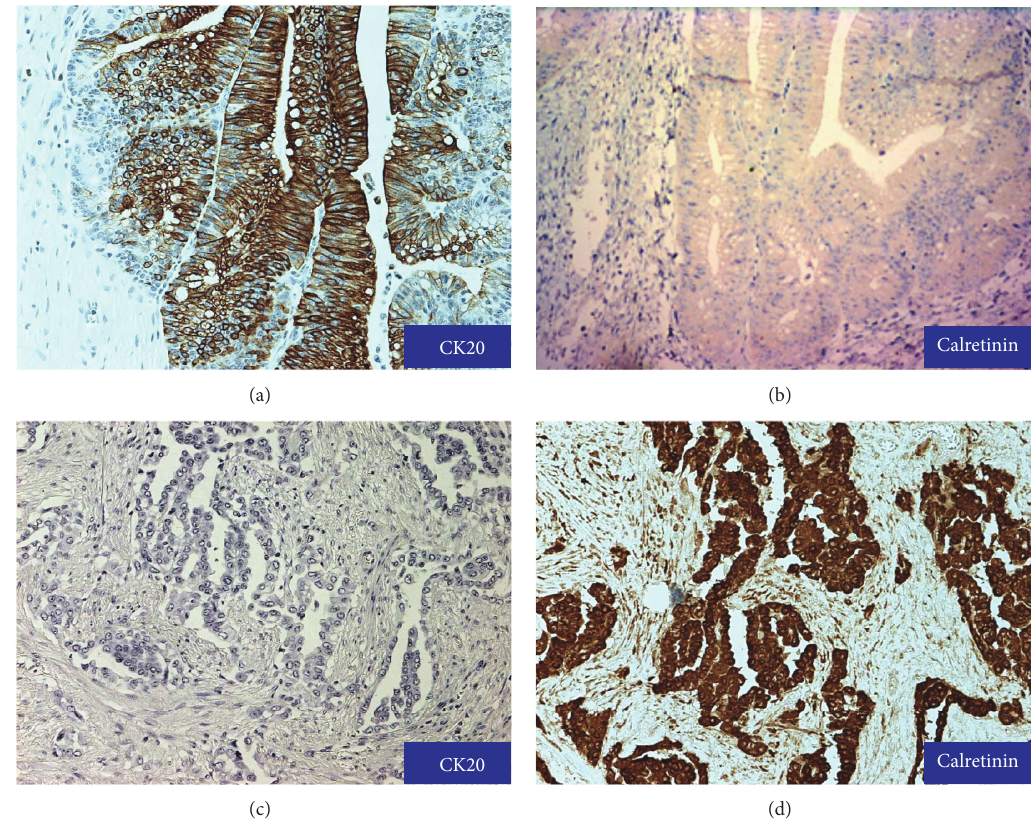
Figure 3: Immunohistochemical staining. (a, b) Adenocarcinoma stained with CK20, but not calretinin. (c, d) Malignant mesothelioma showed negative staining with CK20 and positive immunoreactivity with